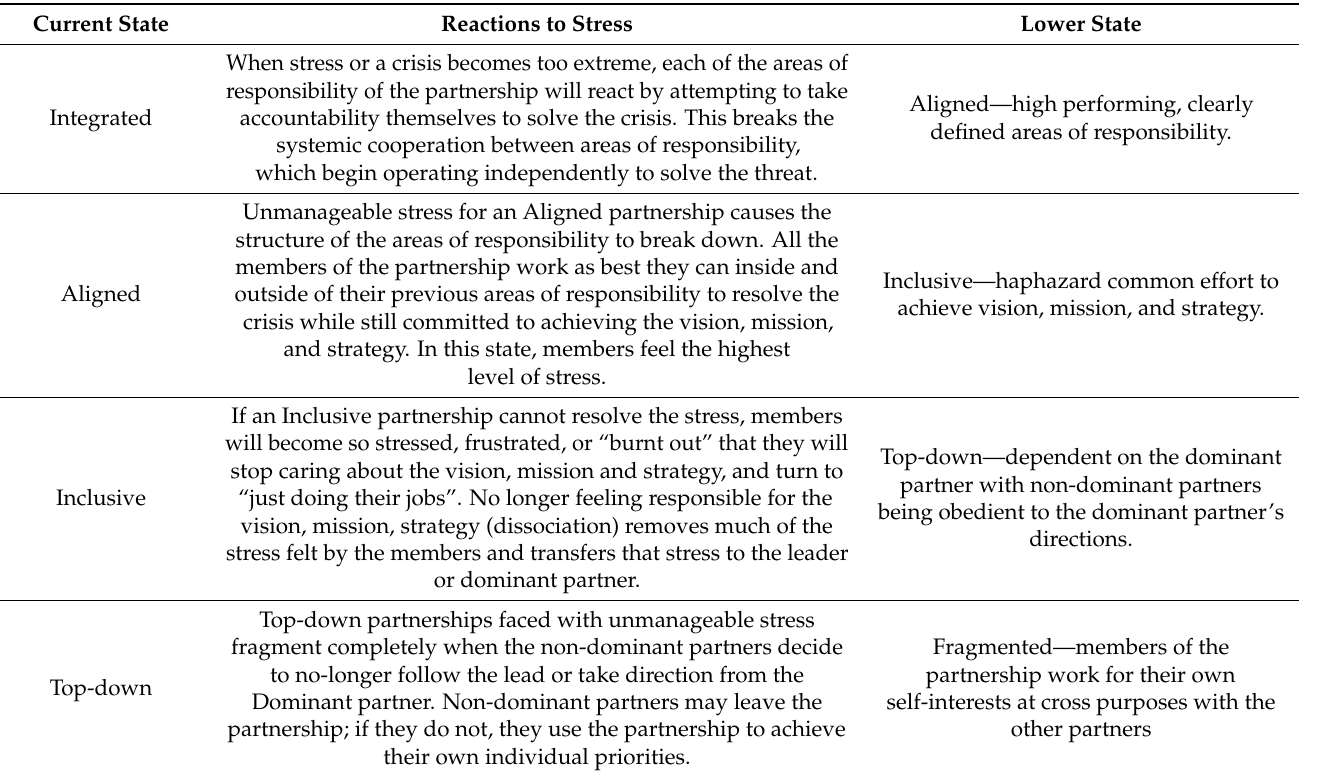
Table 5. Partnership reaction to